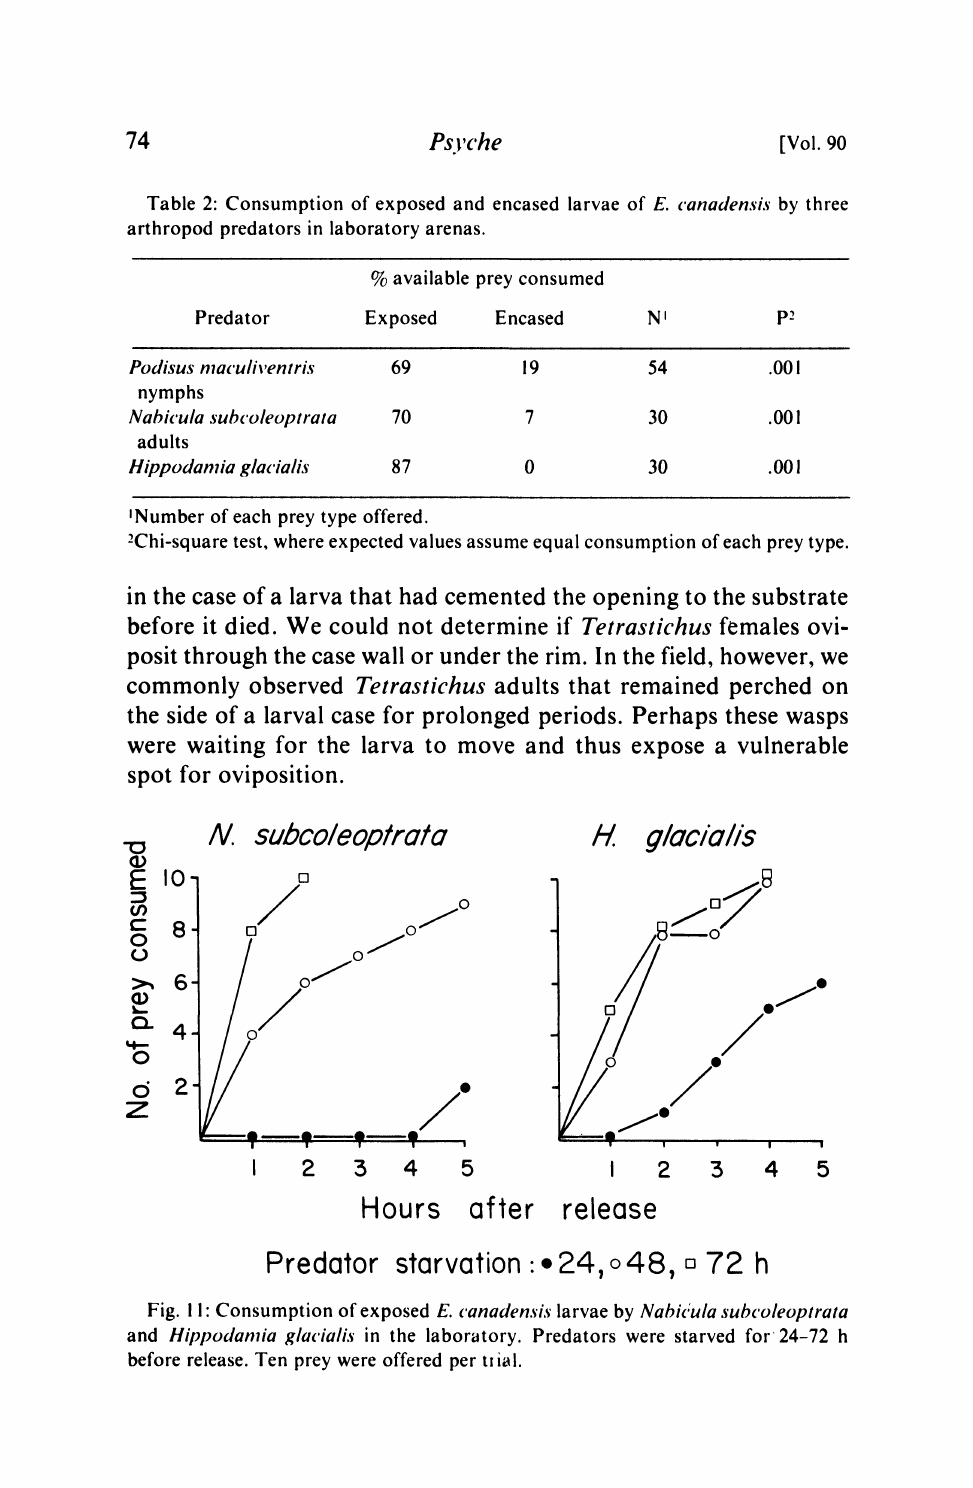
Fig. I" Consumption of exposed E. canadensis larvae by Nabit;ula subcoleoptrata and Hippodamia glacialis in the laboratory. Predators were starved for24-72 h before release. Ten prey were offered per tt